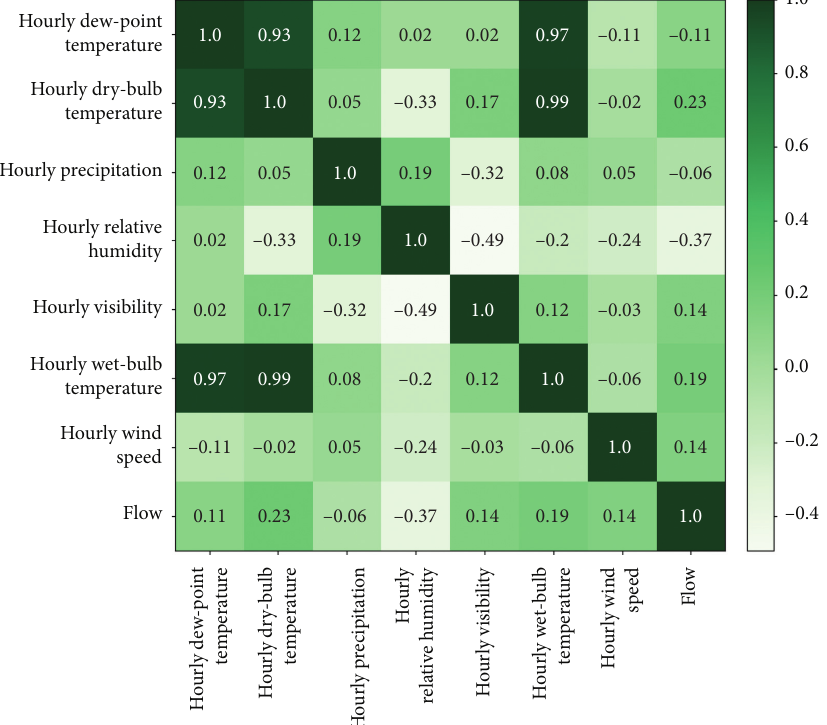
Figure 3: Heat map of PCC of weather parameters and traffic